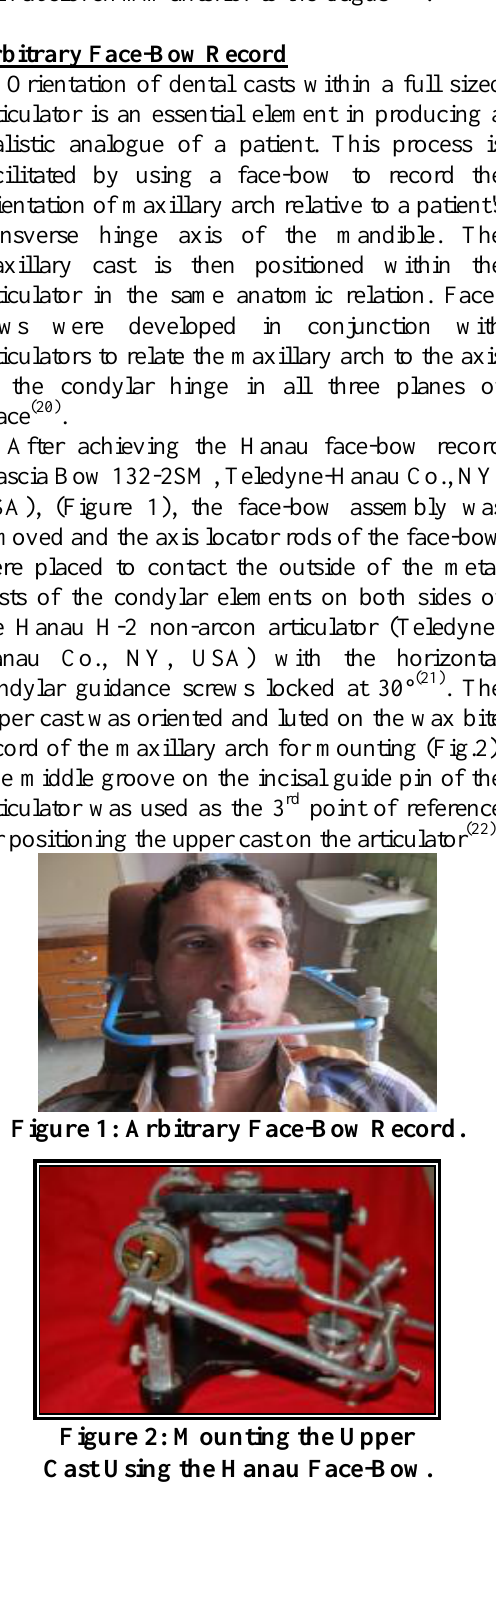
Figure 1: Arbitrary Face-Bow Record.